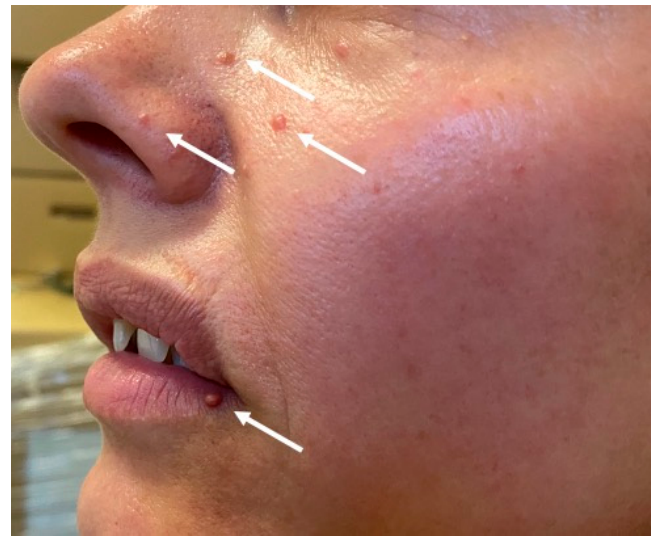
Figure 3. Cutaneous angiofibromas of patient III.3 in the pedigree